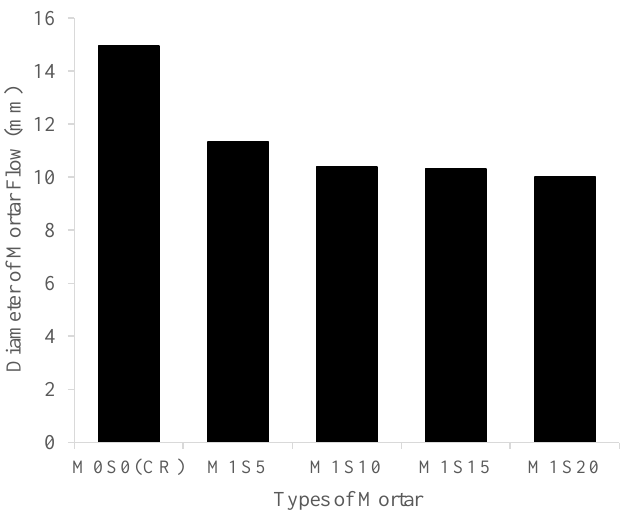
Figure 8. Effects of SF content on the workability of mortars containing 1% SDPMFs.